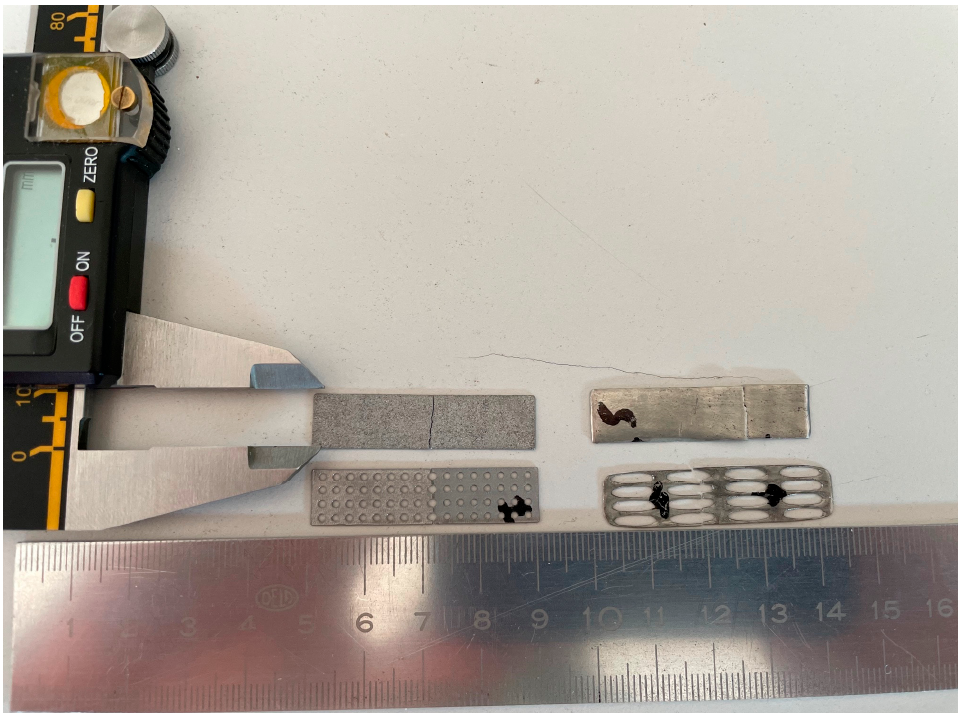
Figure 1. Four of the specimens used for the investigation. Perforated and non-perforated BTK and BoneEasy. The picture was taken after the three-point flexural tests, and it is evident of the fracture of the specimen.